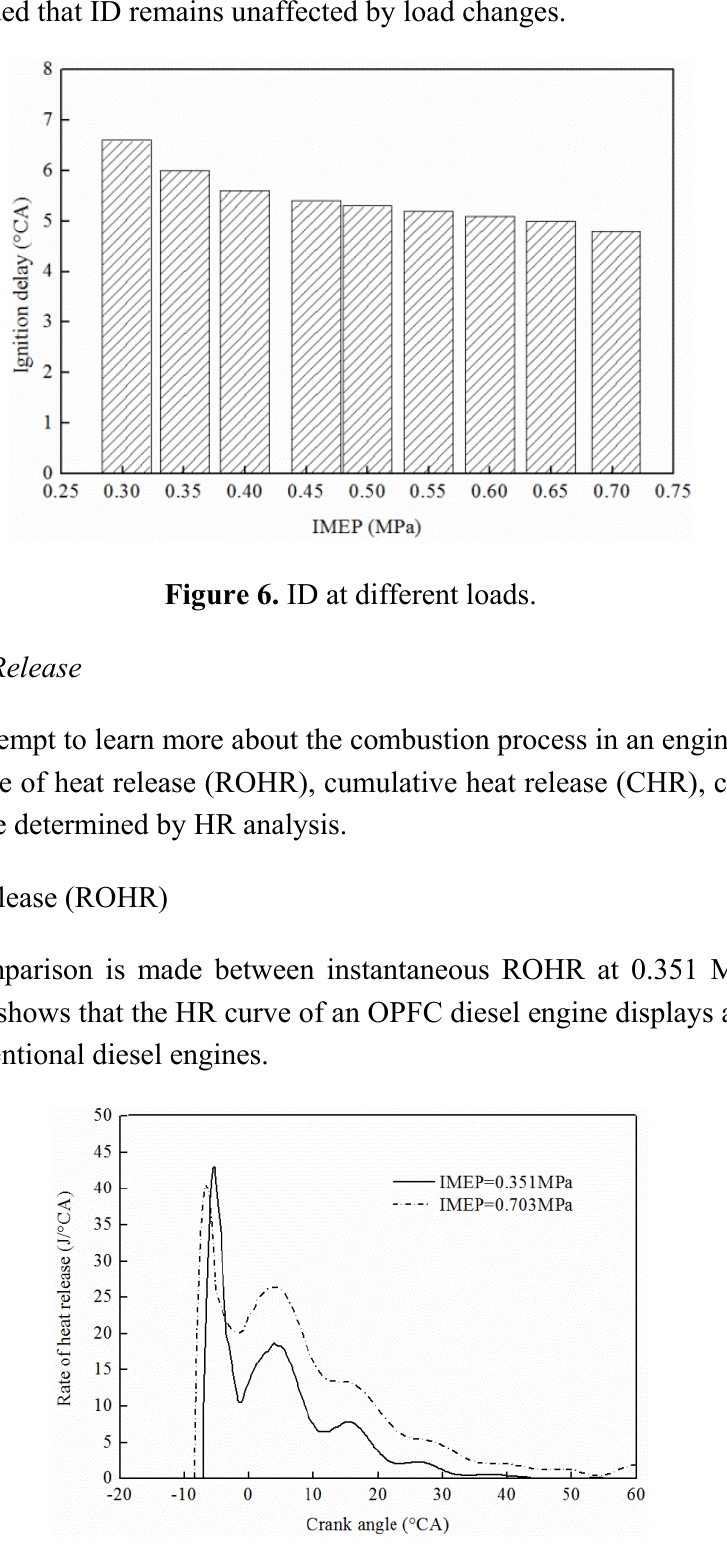
Figure 7. ROHR versus CA for different